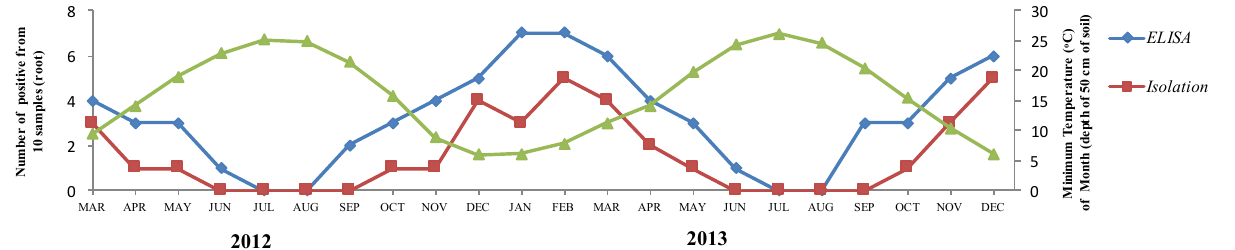
Figure 2. Detection of Xylella fastidiosa in roots of almond trees in orchards during 2012-13.